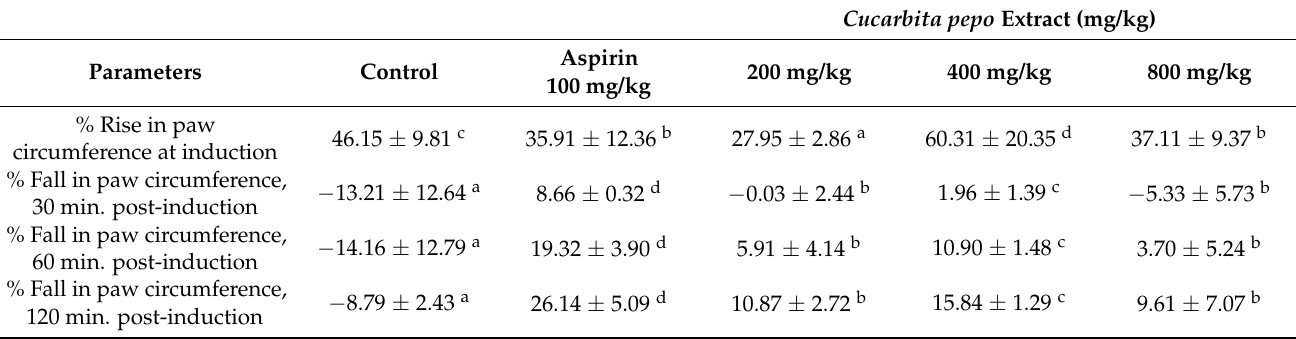
Table 8. Effect of treatments on percentage increase in paw circumferences.